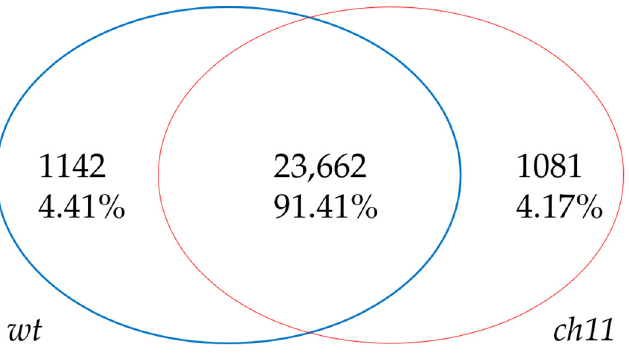
Figure 3. Comparison of gene expression in wild-type ( wt ) and chlorophyll b -deficient ( ch11 ) rices.